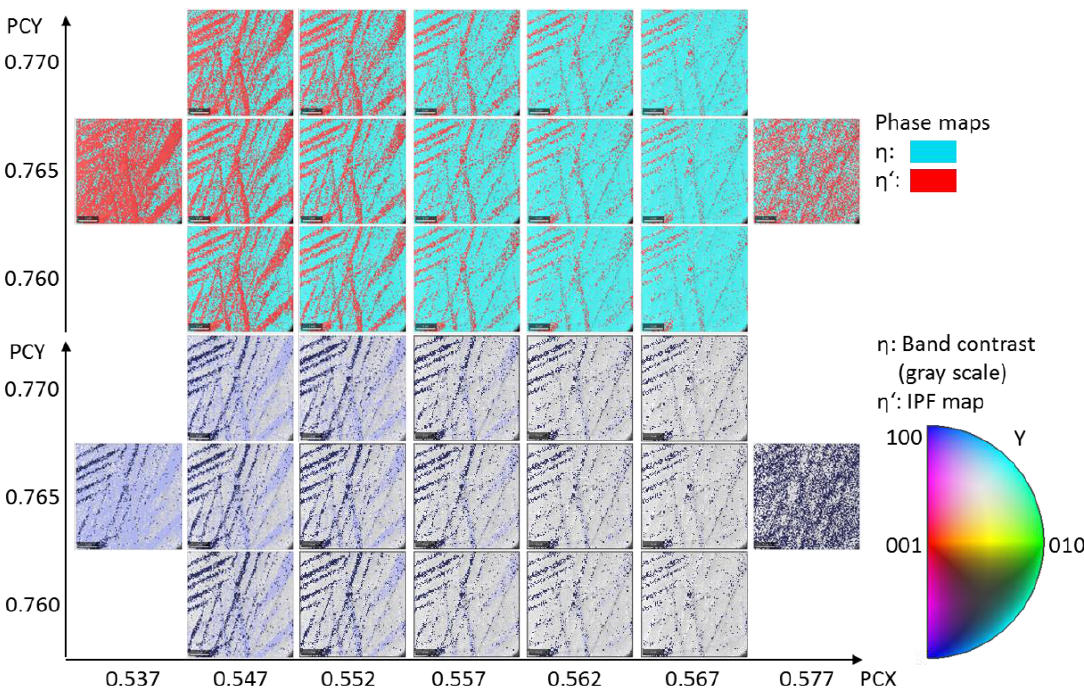
Figure 4. Effect of varying the projection center coordinates PCX and PCY on the indexing result. The significance of choosing the correct projection center is shown for phase separation and identi- fication of the domain orientations. Note that for all tested values for the projection center calibra- tion, the whole map is indexed with a high reliability. The phases in the upper map are colored according to the indicated color code. In the lower orientation maps, the η phase is presented refer- ring to the band contrast while the η′ phase is colored according to inverse pole-figure (IPF) color code with respect to the y direction of the maps.